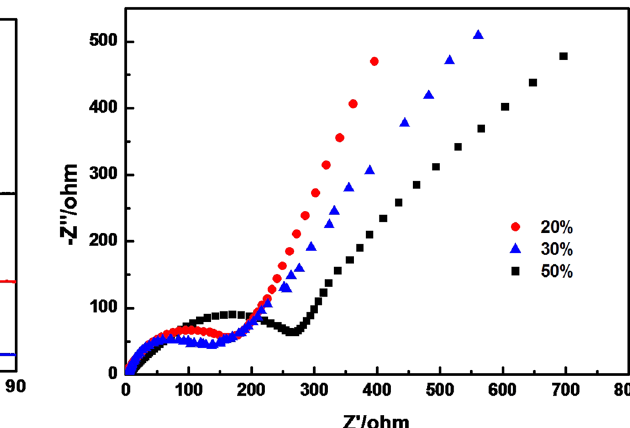
Figure 4: XRD patterns of C@Al – EG composites prepared with di ff erent Al contents.